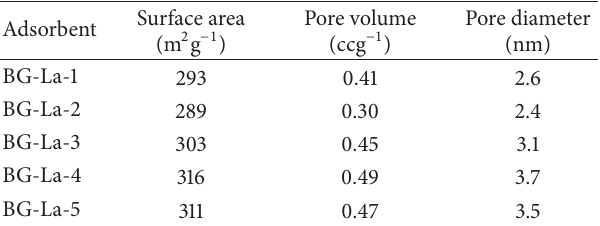
Table 2: Textural and porous parameters of BG-La